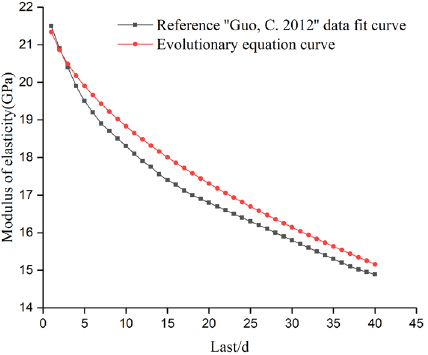
Figure 8. Comparison of changes in modulus of elasticity [34].